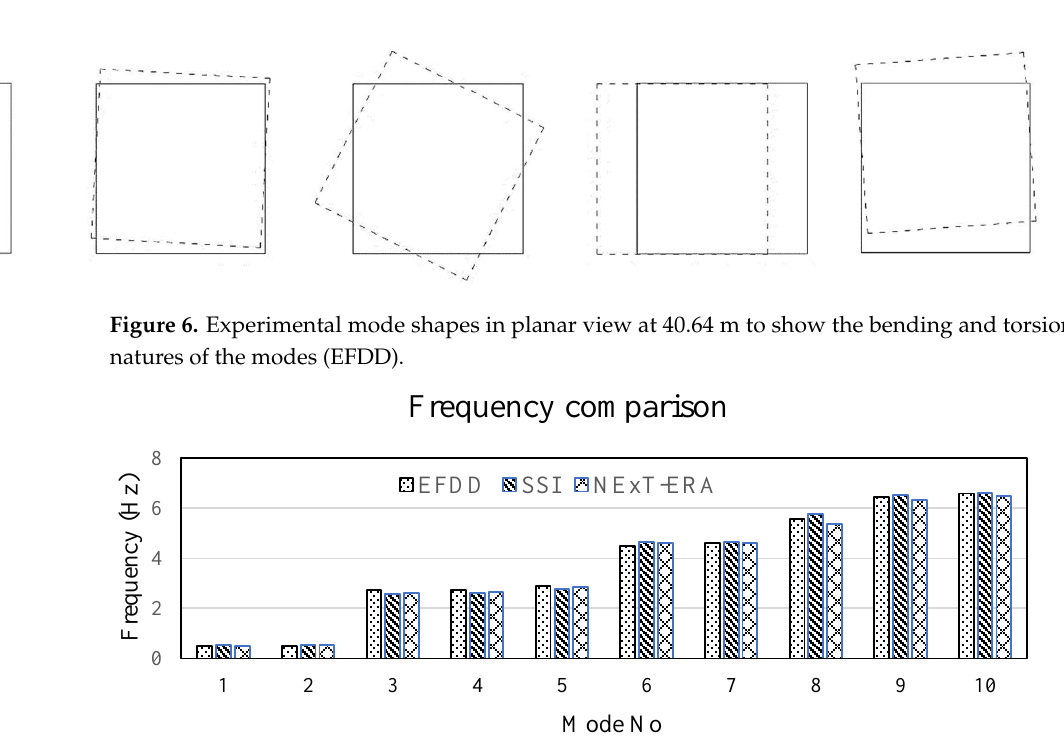
Figure 7. Frequency comparison identified from EFDD, SSI, and NExT-ERA.